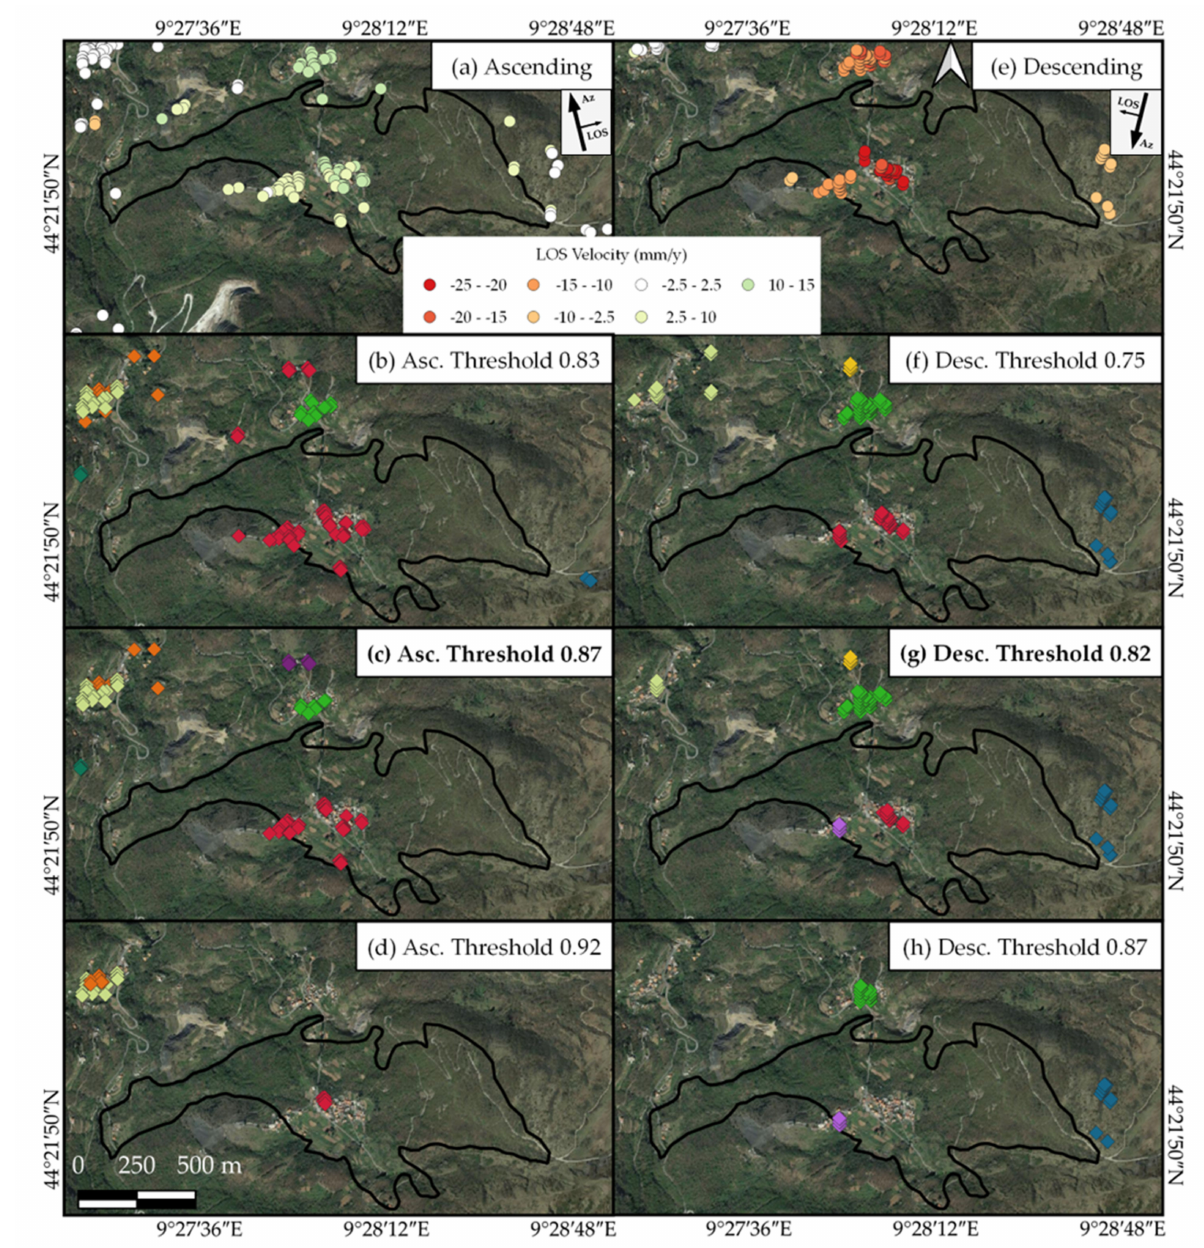
Figure 10. The Arzeno landslide, perimeter in black line according to IFFI [21], with: PS distribution in ( a ) ascending mode and ( e ) descending mode (colour code indicates different LOS velocity ranges), and their subdivision into families with CAPS method by using different threshold values for ( b – d ) ascending and ( f – h ) descending (different colours indicate different PS